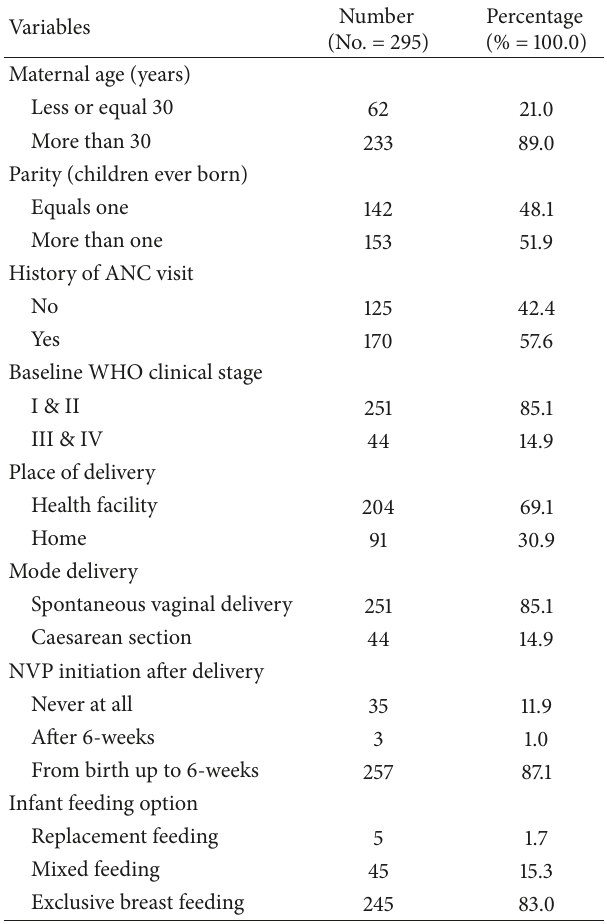
Table 1: Mother-baby pair sociodemographic and clinical charac- teristics at ARRH, Northwestern